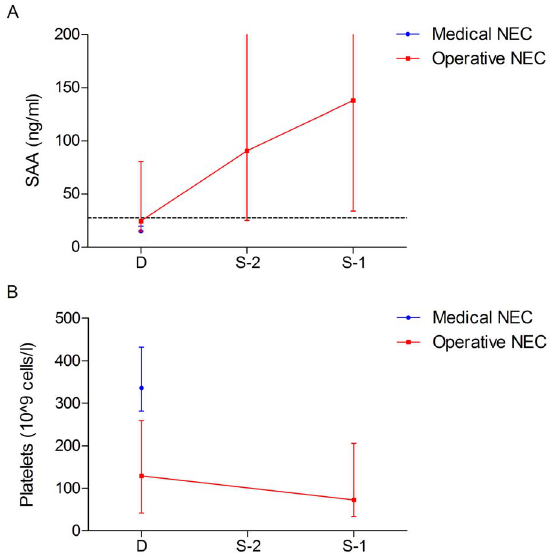
Figure 2. A. Development of urinary SAA levels in patients undergoing surgery 2 or more days after diagnosis. D: day of diagnosis, S-2:2 days prior to surgery; S-1:1 day prior to surgery. A cut-off value of 27.8 ng/ml is depicted by the dotted line. B. Development of platelet levels in patients undergoing surgery 2 or more days after diagnosis. D: day of diagnosis, S-2:2 days prior to surgery; S-1:1 day prior to surgery.